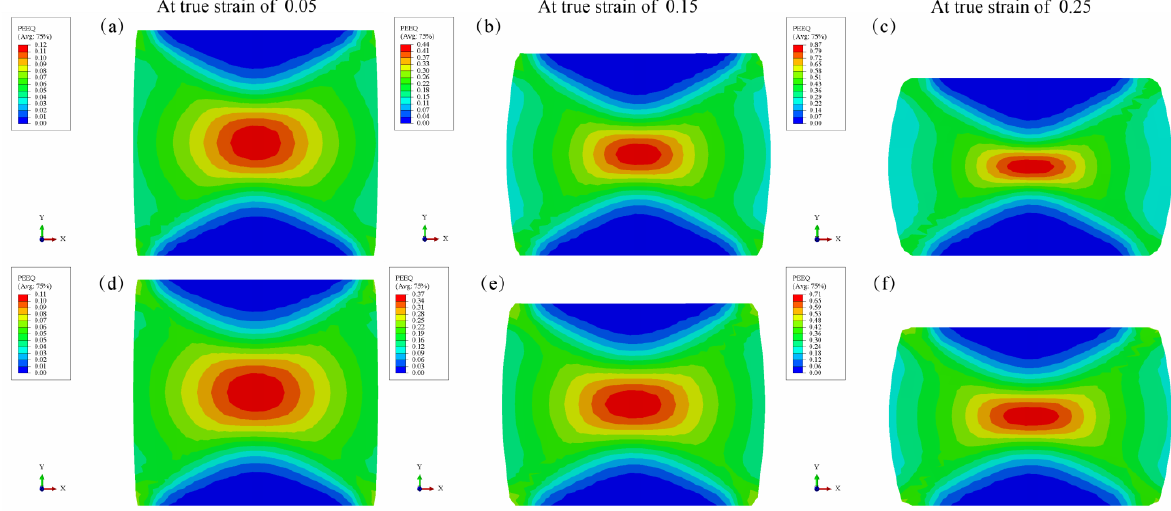
Figure 13. Equivalent plastic strain distribution of the Mg 98.5 Zn 0.5 Y 1 alloy under different defor- mation conditions: ( a ) – ( c ) 200 °C and 0.001 s −1 ; ( d ) – ( f ) 200 °C and 1 s −1